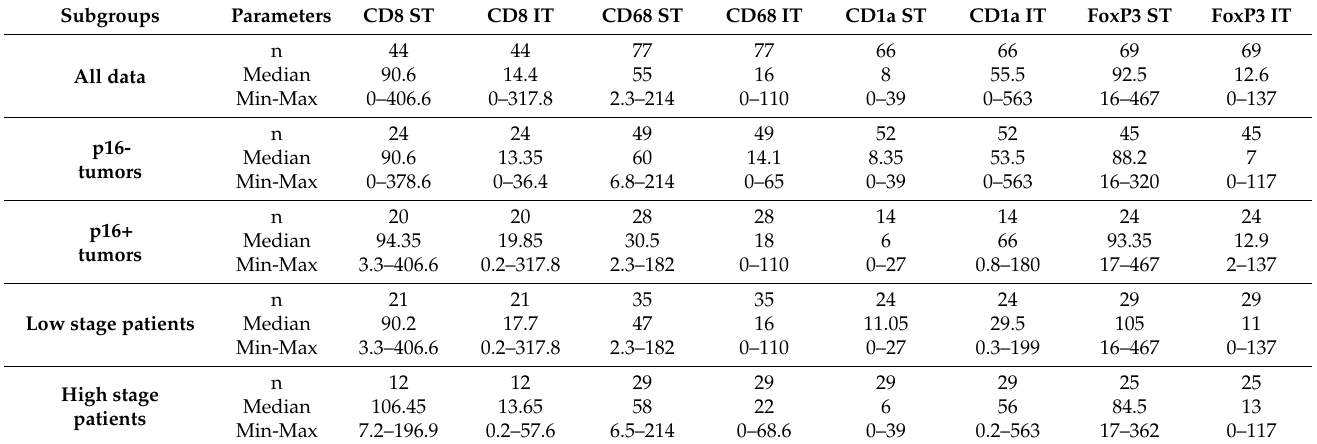
Table 2. Descriptive table of immune cell density according to different subgroups including p16- negative, -positive, low-stage and high-stage patients.